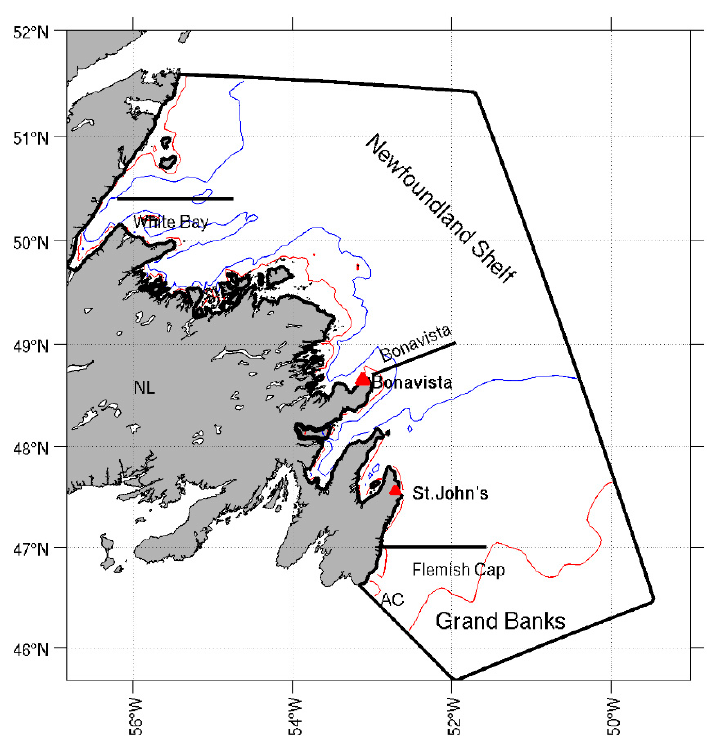
Figure 1. Map showing the Newfoundland Shelf off the eastern Newfoundland coast as well as the model boundaries (thick solid lines). The isobaths displayed are 100 (red line) and 200 (blue line) m. AC is the Avalon Channel. NL is Newfoundland. Three transects are White Bay, Bonavista, and Flemish Cap. Two red triangles indicate tide-gauge stations.